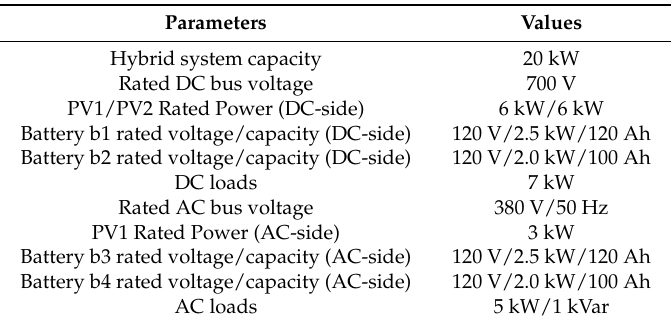
Table 1. Parameters of the hybrid system.